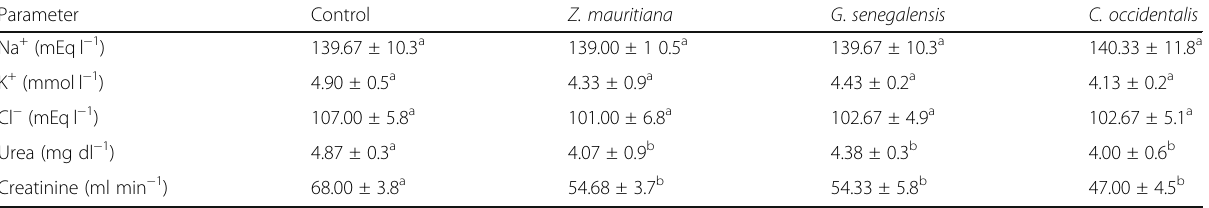
Table 5 Kidney parameters of the rats treated with Z. mauritiana , C. occidentalis , and G. senegalensis Parameter Control